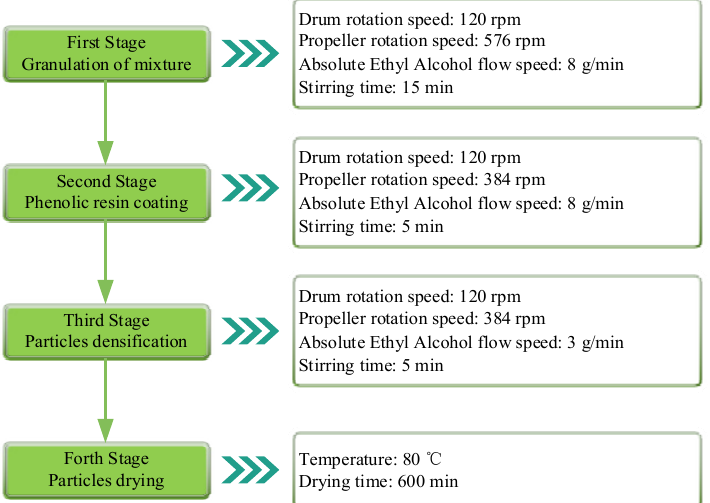
Figure 2. The granulation method of the mixture.